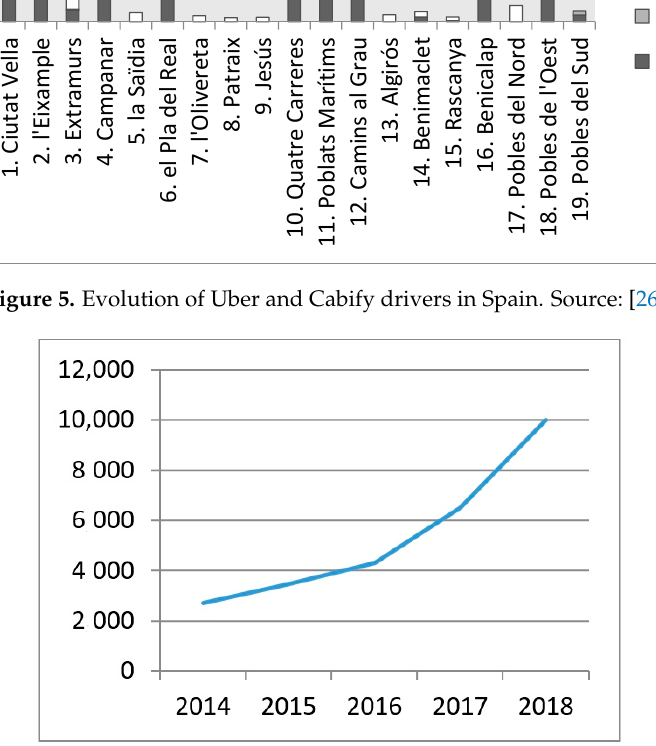
Figure 6. Accommodation options per district in Valencia. Source: [27].